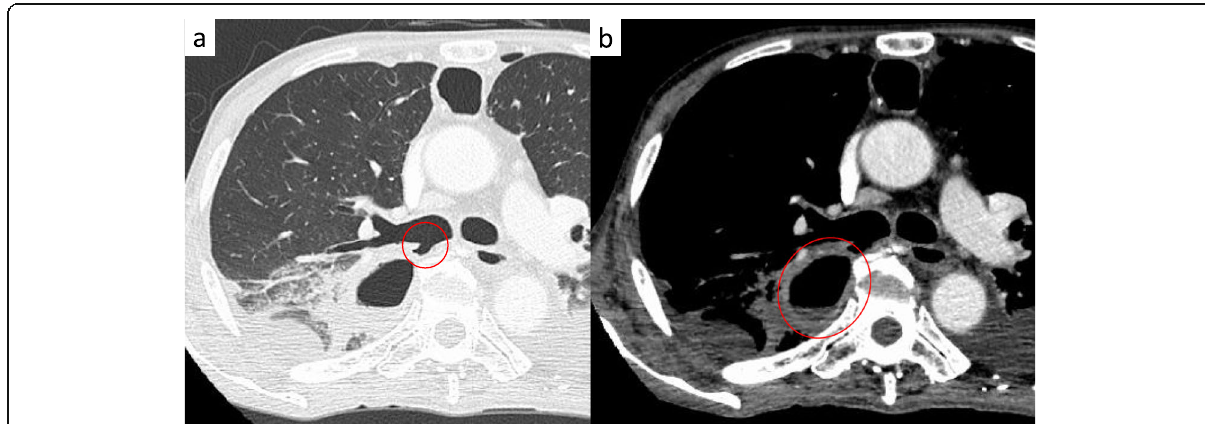
Fig. 2 Chest CT scan images showing a a defect in the membranous portion of the right main bronchus and b an air space and air – fluid level near the right main bronchus